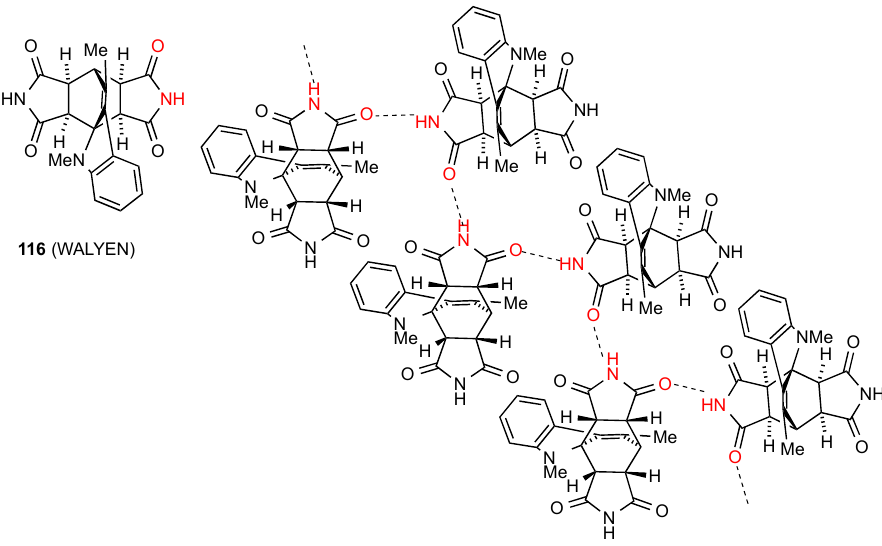
Figure 40. Structure adopted by compound 115.